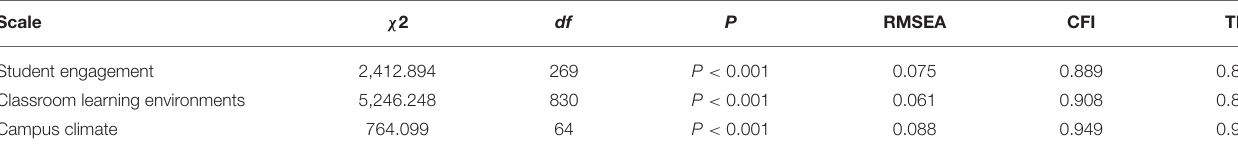
TABLE 2 | CFA results.